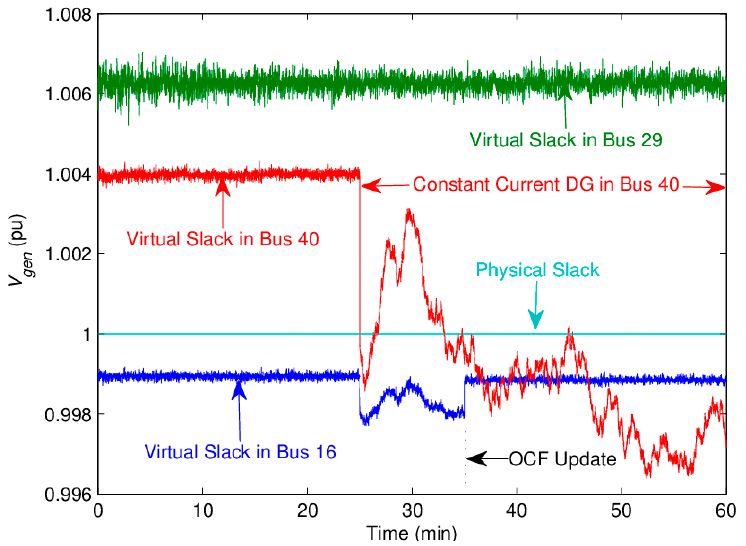
Figure 11. Voltages according to losing slack control and optimal current flow (OCF) update.